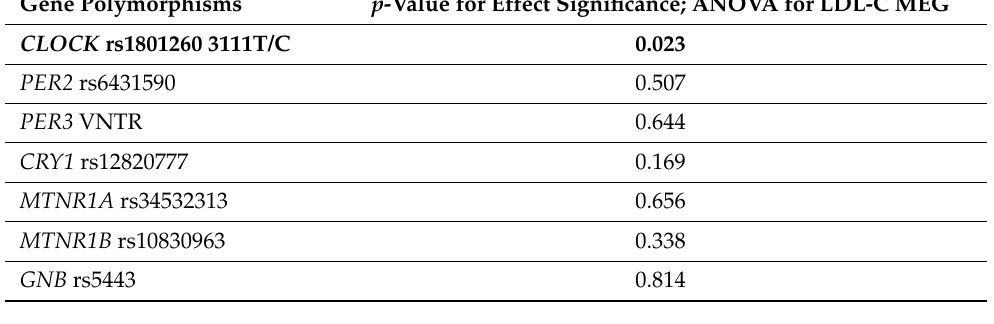
Table 2. Morning–evening gradients (MEGs) of low-density lipid cholesterol (LDL-C) depended on studied polymorphic variants of the biological clock, melatonin receptors, and G-protein genes in primary-open glaucoma patients (n = 19). Significant correlations are bold.